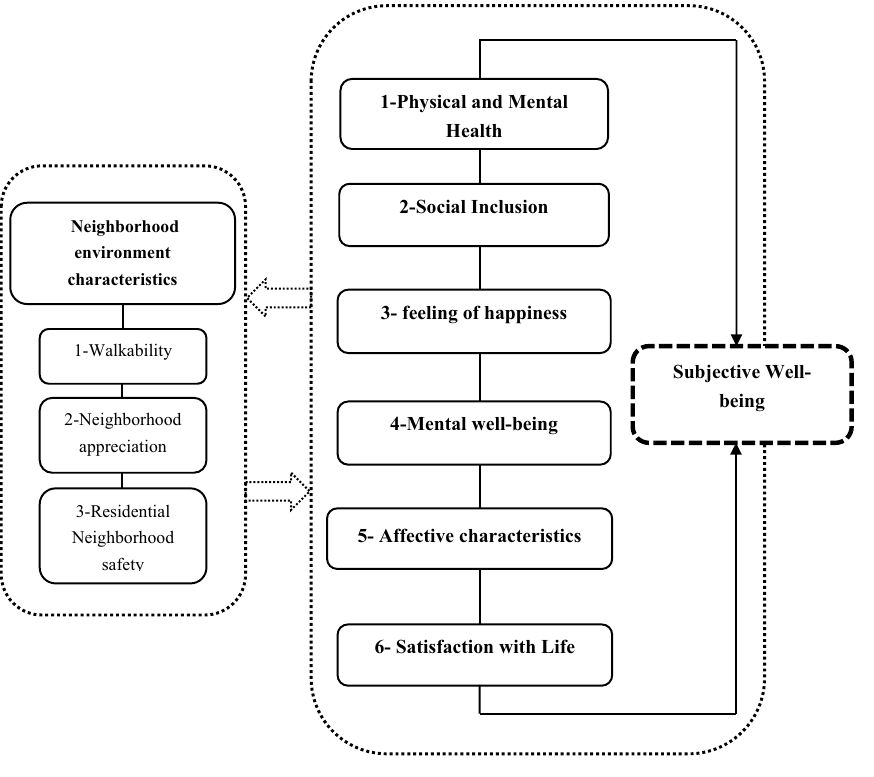
Figure 3. The conceptual framework and the relationship between neighborhood environment characteristics and major dimensions of subjective well-being.